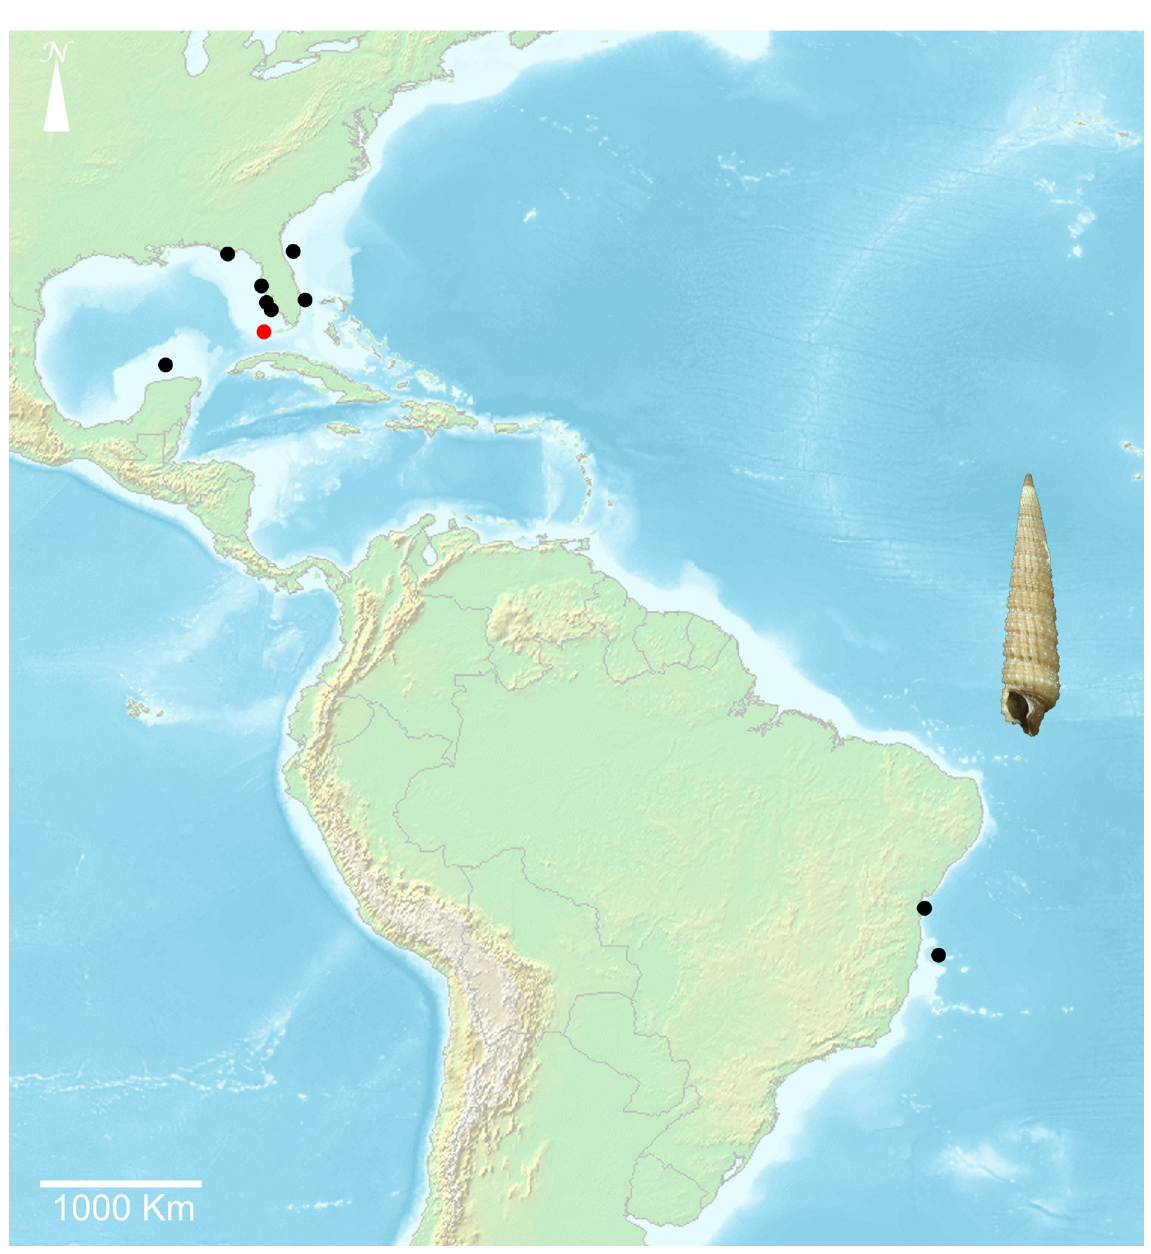
Fig. 33. Distribution map of Eutriphora auffenbergi Rolán & Lee, 2008; red circle = type